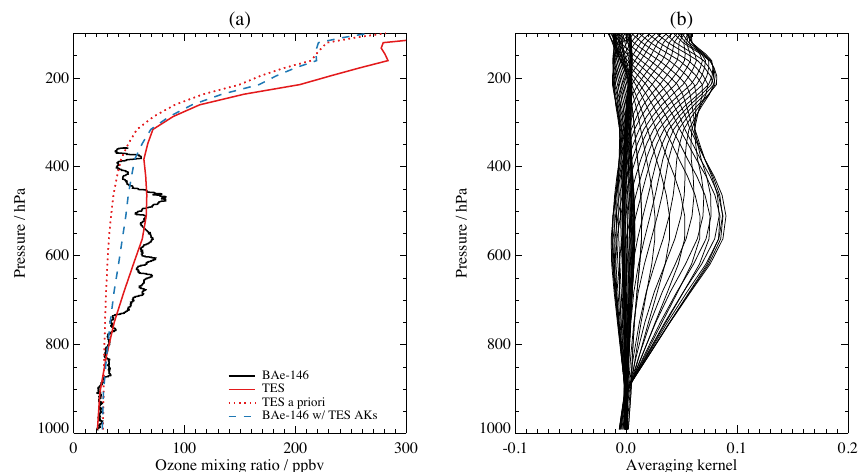
Fig. 12. Ozone profiles measured during a descent of the BAe-146 into Thunder Bay, ON, on 26 July 2011. Plot (a) shows the O 3 profile measured from the BAe-146 (solid black line), retrieved from the collocated TES measurements and its prior (solid and dotted red lines, respectively), and the aircraft profile smoothed with the TES averaging kernels. Plot (b) shows the averaging kernels for the TES O 3 profile retrieval.